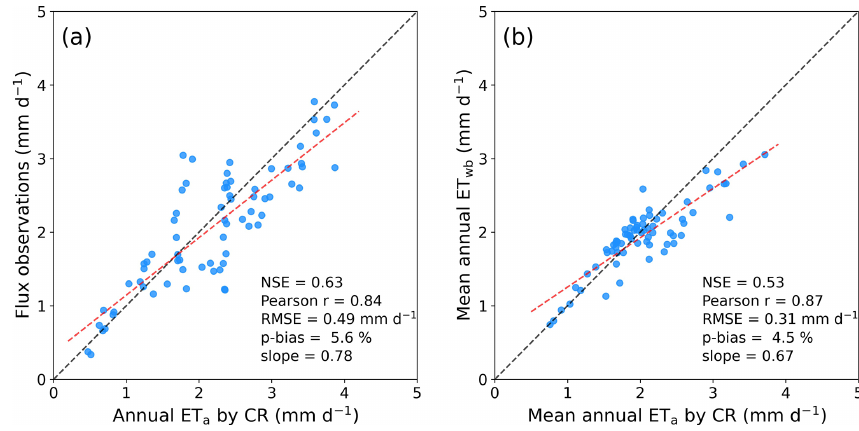
Figure 6. Same as Fig. 2 except that the ˜ α e values from Eq. (17) were used for CR ET a .